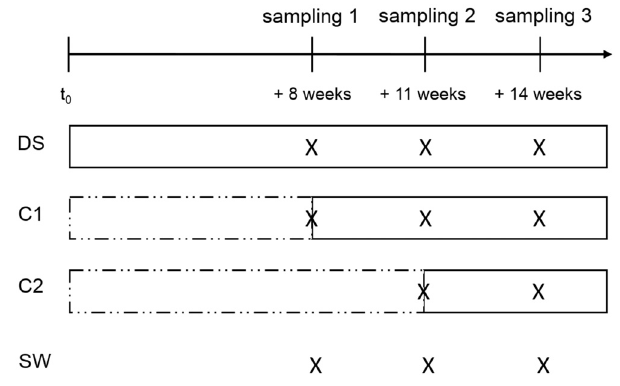
Fig. 2. Overview of the experimental design. Treatments: DS = direct seeded line, C1 =collector 1, C2 = collector 2, SW= seawater. X indicates the samplings, broken lines indicate the time of sporophytes grown in laboratory conditions and full lines the time of sporophytes grown in the fi eld.